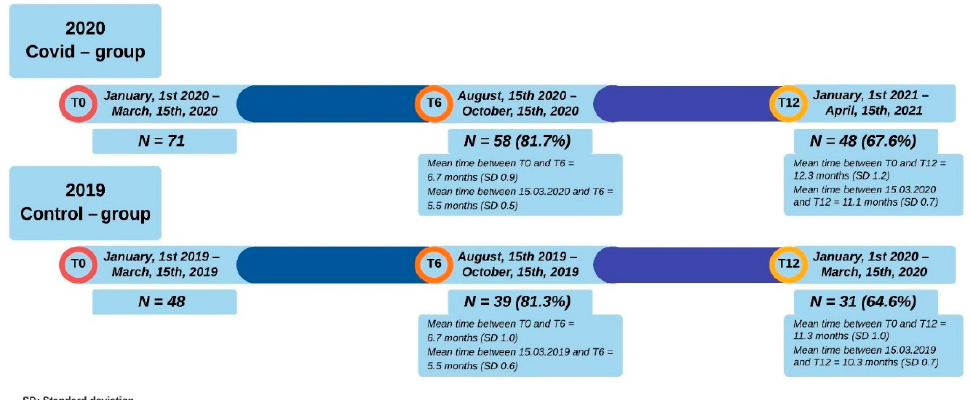
Figure 1. Timeline and inclusion at the several measurement moments for the 2020 COVID-19 group and the 2019 control group.